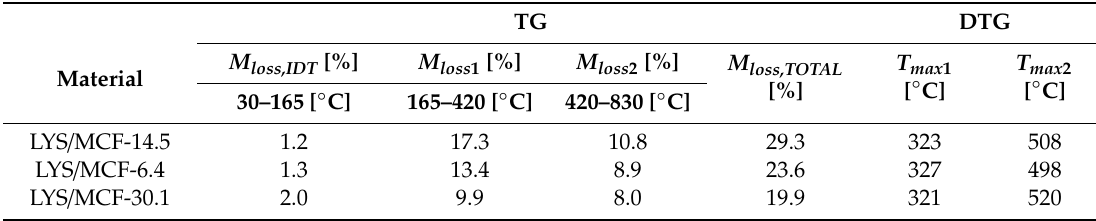
Table 5. TG and DTG data obtained in air atmosphere for LYS / MCF